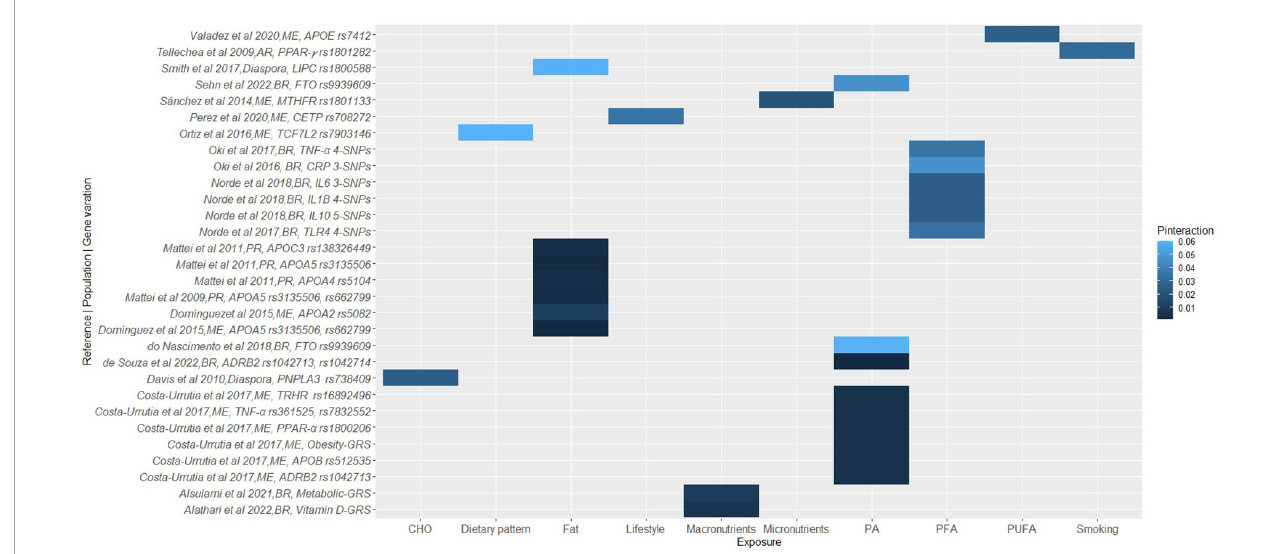
FIGURE1 A heat map showing the findings for gene-lifestyle interactions on overall cardiometabolic disease risk. Alsulami et al. (72), Metabolic-GRS = TCF7L2 (rs12255372, rs7903146); MC4R (rs17782313, rs2229616); PPAR γ (rs1801282); FTO (rs8050136); CDKN2A/2B (rs10811661); KCNQ1 (rs2237892); CAPN10 (rs5030952); Alathari et al. (73), Vitamin D-GRS = VDR (rs2228570, rs7975232), DHCR7 (rs12785878), CYP2R1(rs12794714), CYP24A1(rs6013897), GC (rs2282679), FTO (rs8050136, rs10163409), TCF7L2 (rs12255372, rs7903146), MC4R (rs17782313), KCNQ1 (rs2237895, rs2237892), CDKN2A (rs10811661), PPAR γ (rs1801282), CAPN10 (rs5030952); Costa-Urrutia et al. (118), Obesity-GRS = ABCA1 (rs2230806, rs9282541); ADIPOQ (rs2241766); ADRB2 (rs1042713); AGT (rs699); APOA4 (rs675); APOB (rs512535); APOE (rs405509); CAPN10 (rs2975760, rs2975762, rs3792267); FTO (rs1121980, rs9939609); HNF4 (rs745975); LIPC (rs1800588); LPL (rs320); PPAR- α (rs1800206); PPAR- γ (rs1801282); SCARB1 (rs1084674); TCF7L2 (rs7903146); TNF (rs361525); TRHR (rs1689249, rs783255 2); Norde et al. (79), 5-SNPs = IL10 rs1554286, rs1800871, rs1800872, rs1800890, rs3024490 ; Oki et al. (78), 4-SNPs = TNF- α rs1799724, rs1800629, rs361525, rs1799964; Norde et al. (76), 4-SNPs = TLR4 rs11536889, rs4986790, rs4986791, rs5030728; Oki et al. (77), 3-SNPs = CRP rs1205, rs1417938, rs2808630; Norde et al. (79), 4-SNPs = IL1B rs16944, rs1143623, rs1143627, rs1143643; 3-SNPs = rs1800795,